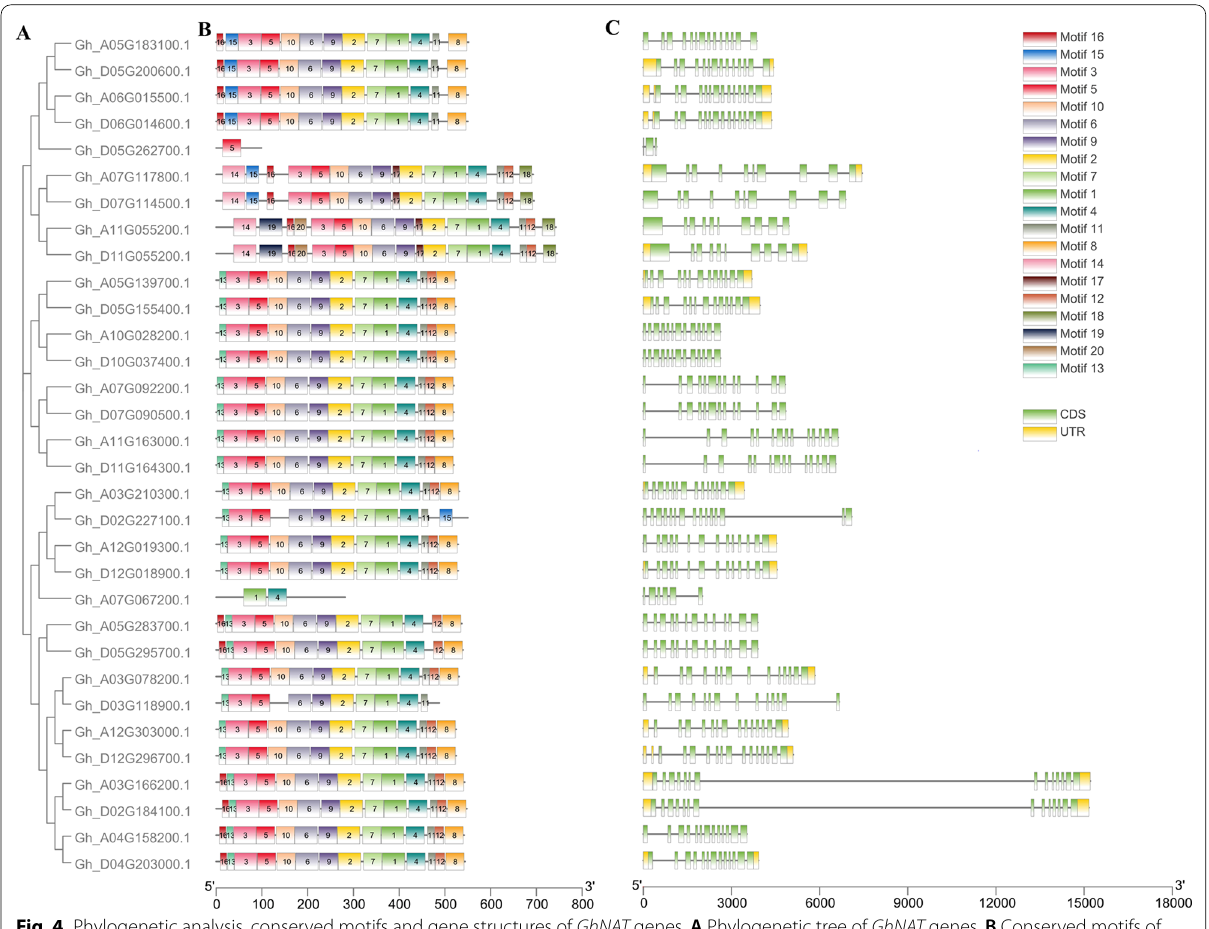
Fig. 4 Phylogenetic analysis, conserved motifs and gene structures of GhNAT genes. A Phylogenetic tree of GhNAT genes. B Conserved motifs of GhNAT proteins. Twenty conserved motifs are represented by different color boxes. C Exon–intron organization analyses of GhNAT genes. Yellow boxes mean Untranslated Regions (UTR), Exons and introns are distinguished by green boxes and black lines,